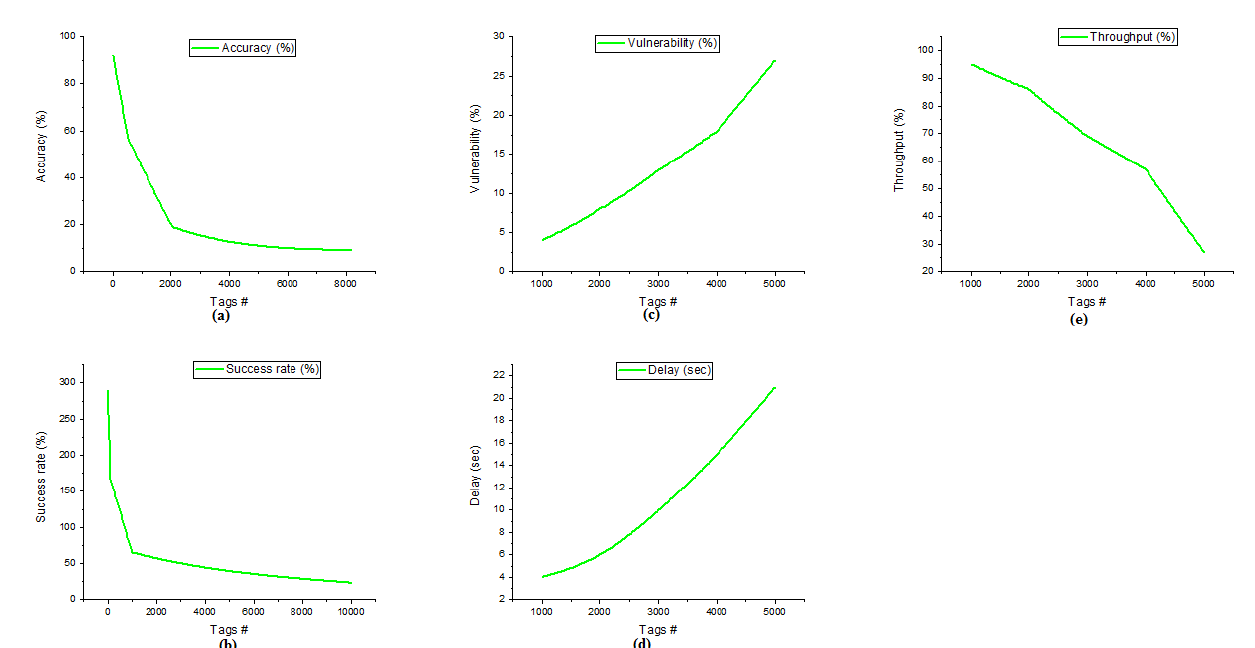
Figure 4. ( a ) Accuracy of ODBC ( b ) Success rate of ODBC ( c ) Vulnerability of ODBC ( d ) Delay of ODBC ( e ) Throughput of ODBC.